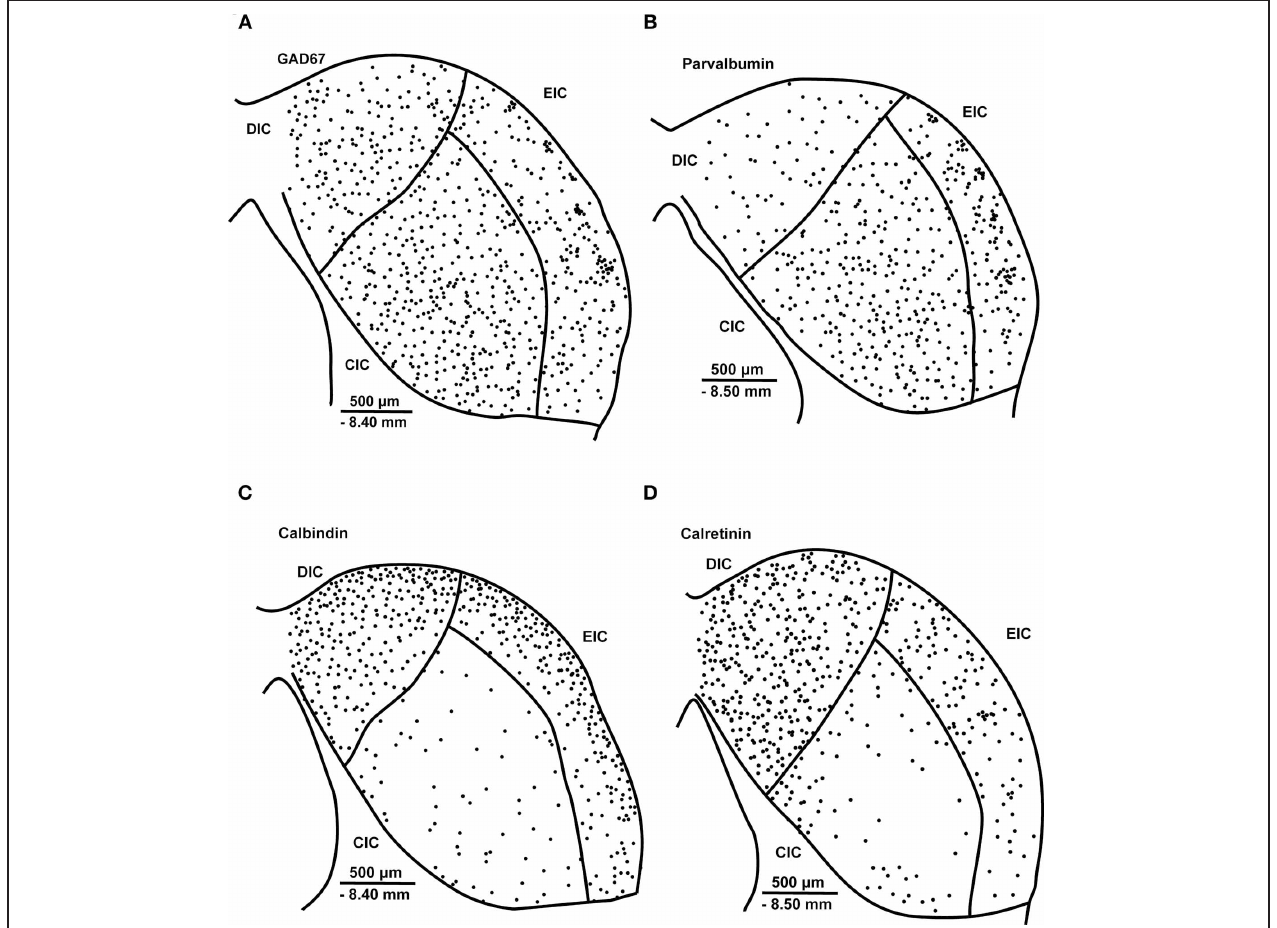
cortex of the inferior colliculus; GAD67, glutamate decarboxylase, isoform 67; PV, parvalbumin; CB, calbindin; CR, calretinin. The distance from bregma and scale bars are provided in each panel. The displayed schema is based on the distribution of GAD67-, PV-, CB-, and CR-ir neurons observed in our previous publications (Ouda et al., 2008; Burianova et al., 2009; Ouda et al.,